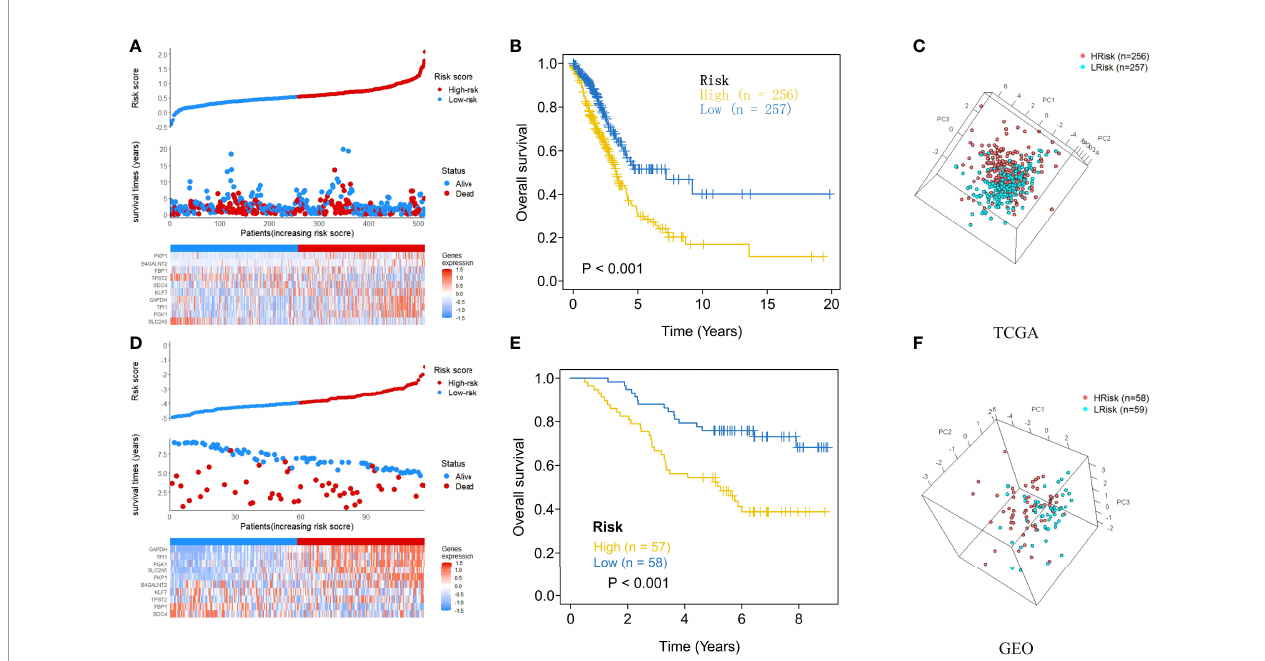
FIGURE 3 | The risk score plots, OS status plots, and heatmaps of these 10 hypoxia-associated genes in the TCGA and GEO groups. (A) Risk score distribution, OS status, and the expression of 10 hypoxia-associated genes of LUAD patients in TCGA group. Red means high risk, blue means low risk. (B) Kaplan – Meier plot found that the HAGS divided patients into high- and low-risk groups with signi fi cant difference in OS. (C) Based on PCA analysis, the 513 LUAD patients in TCGA were distributed into two sections according to the risk score. (D – F) Similar results were also found in the GEO group. OS, overall survival; PCA, principal component